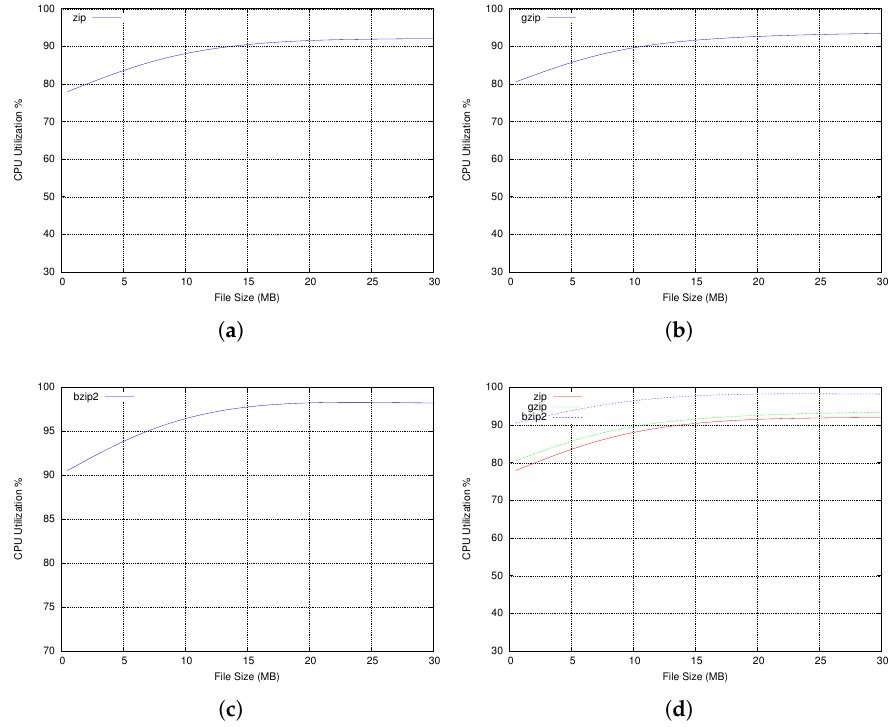
Figure 8. CPU utilization by SH-VARR snapshot based on three compression algorithms. ( a ) Using zip algorithm; ( b ) Using gzip algorithm; ( c ) Using bzip2 algorithm; ( d ) All algorithms.